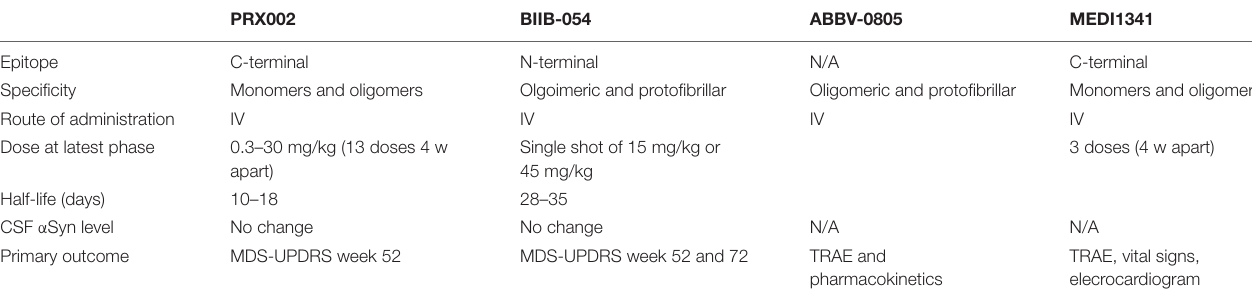
TABLE 4 | Characteristics of passive immunotherapy for Parkinson’s